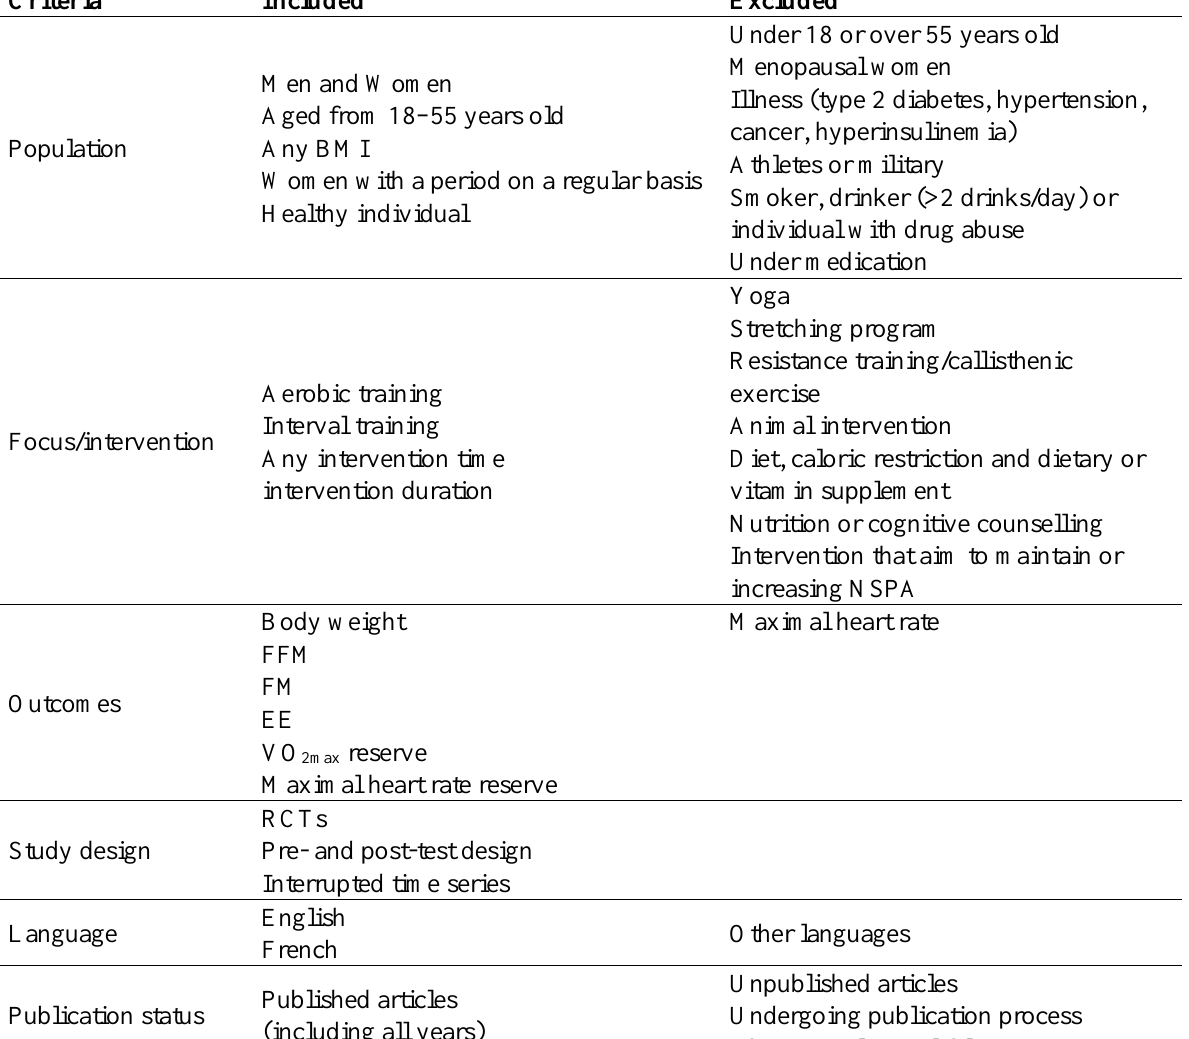
Table 1. Criteria of included and excluded items for study selection. FFM, fat-free mass; FM, fat mass; EE, energy expenditure; NSPA, non-structured physical